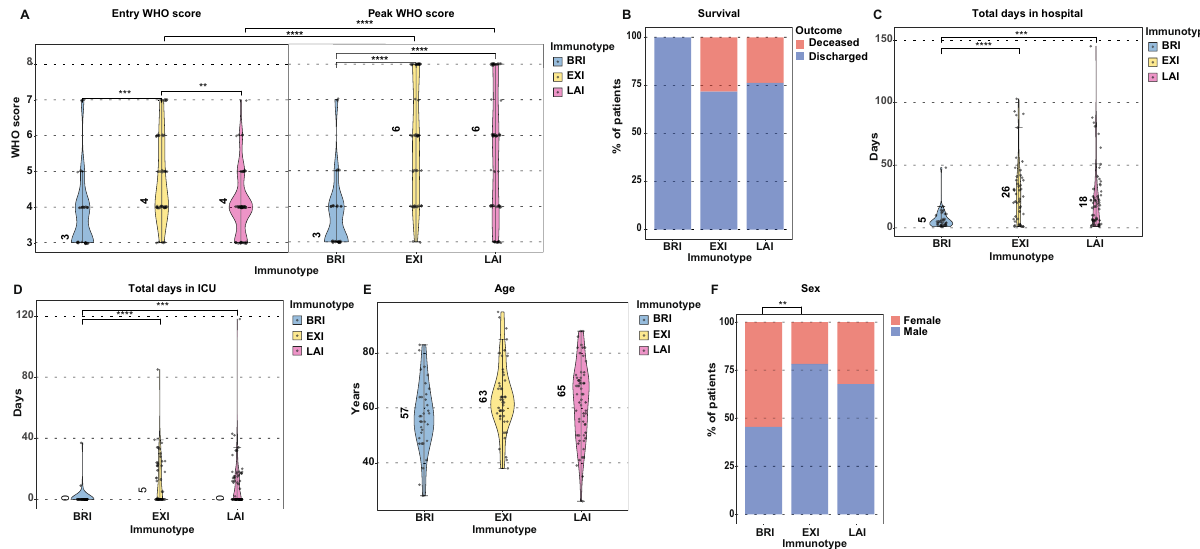
Fig. 3 Immunotypes predict clinical improvement or deterioration in acute COVID-19. COVID-19 immunotype BRI identi fi es at study entry patients that will clinically improve while immunotypes EXI and LAI predict clinical deterioration as peak severity scores during hospitalization are higher than entry scores. Violin plots and stacked bar graphs show per immunotype A WHO clinical score at study entry and peak WHO clinical score during hospitalization, B Percentage of deceased patients, C total days in the hospital, D total days in the ICU, E Age of patients and F Percentage of females and males. Data shown are from BRI ( n = 33), EXI ( n = 46), and LAI ( n = 59) patients. Medians indicated by number in plots. Whiskers depict the 1.5x IQR value. Signi fi cance between the three immunotypes for the WHO scores was tested using a two-sided Wilcoxon rank-sum test with Bonferroni correction. Signi fi cance for each immunotype between entry WHO score and peak WHO score was tested using a paired Wilcoxon rank-sum test. Signi fi cant differences in total days in hospital and ICU were tested using two-sided Wilcoxon rank-sum tests with Bonferroni correction, signi fi cant differences in age were tested using two-sided Student ’ s t -tests with Bonferroni correction, signi fi cance difference in sex distribution was tested using a chi-square test; * p < 0.05, ** p < 0.01, *** p < 0.001, and **** p <